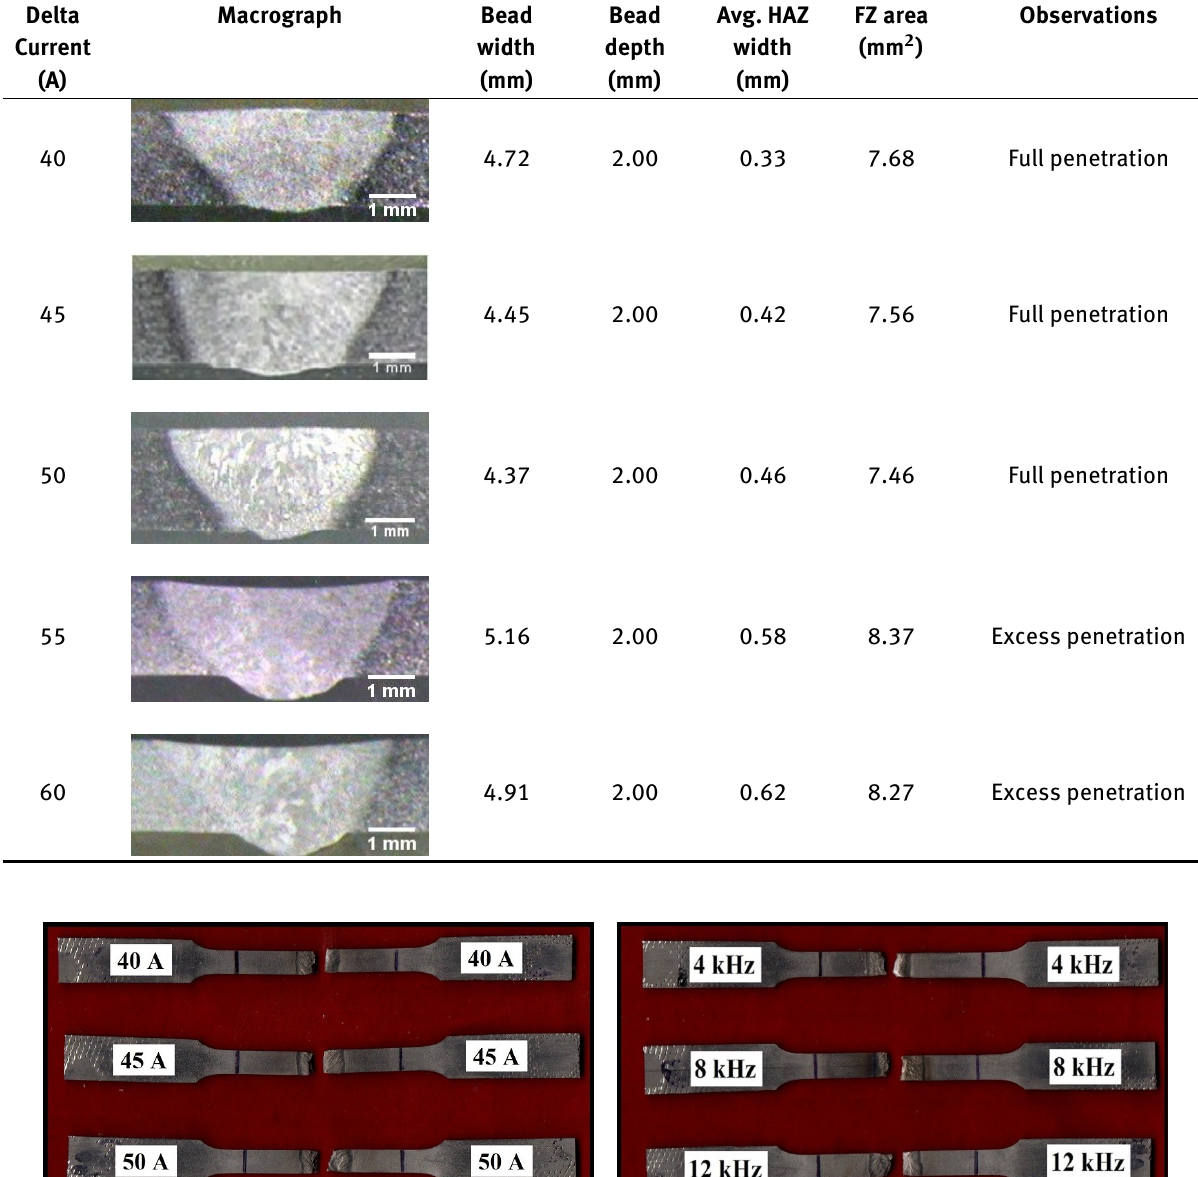
Table 4: Effect of Delta Current on weld bead geometry Delta